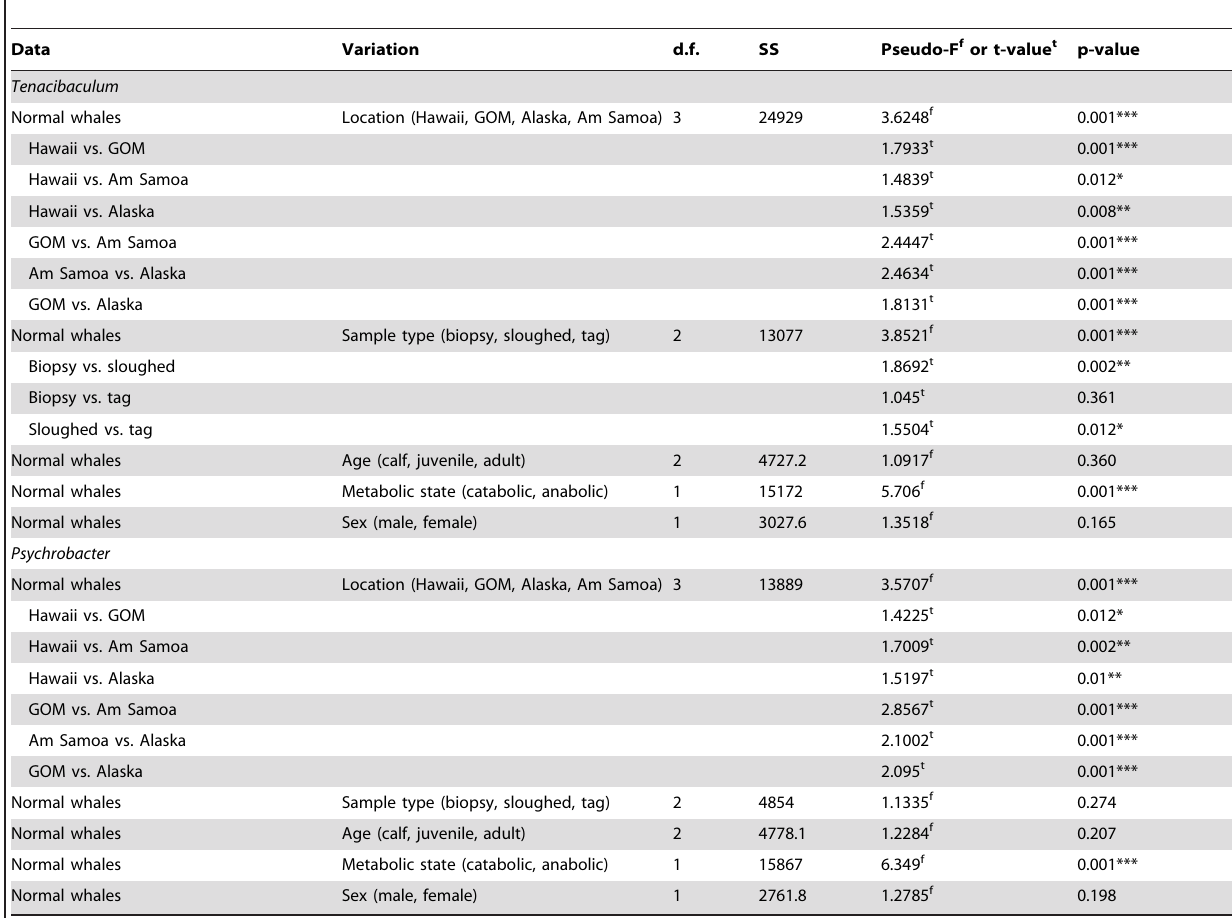
Table 5. PERMANOVA analysis of the effect of geographic area, age, sex and sample type on Tenacibaculum and Psychrobacter spp. populations determined by oligotyping.